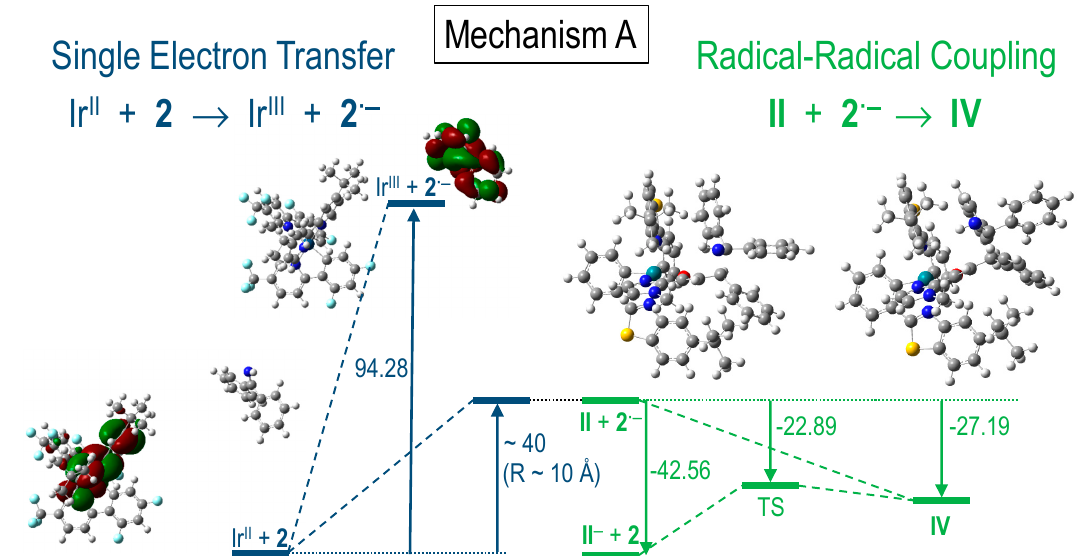
Figure 1. Relevant points in the potential energy of the two steps in mechanism A: single electron transfer in the reduction of imine by the photocatalyst (see details in Figure 2) and radical–radical coupling. Relative energies in kJ·mol − 1 are referred to the separated reactants and have been corrected with the zero-point energy E+ZPE.